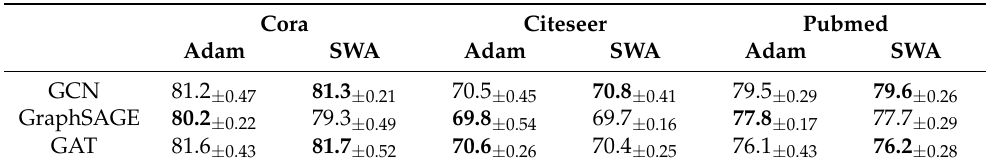
Table 3. Test accuracy (%) comparison between Adam and SWA for the graph-classification task on datasets NCI1, D&D, and PROTEINS. Best results are bolded . NCI1 D&D PROTEINS Adam SWA Adam SWA Adam SWA MinCutPool 74.78 ±